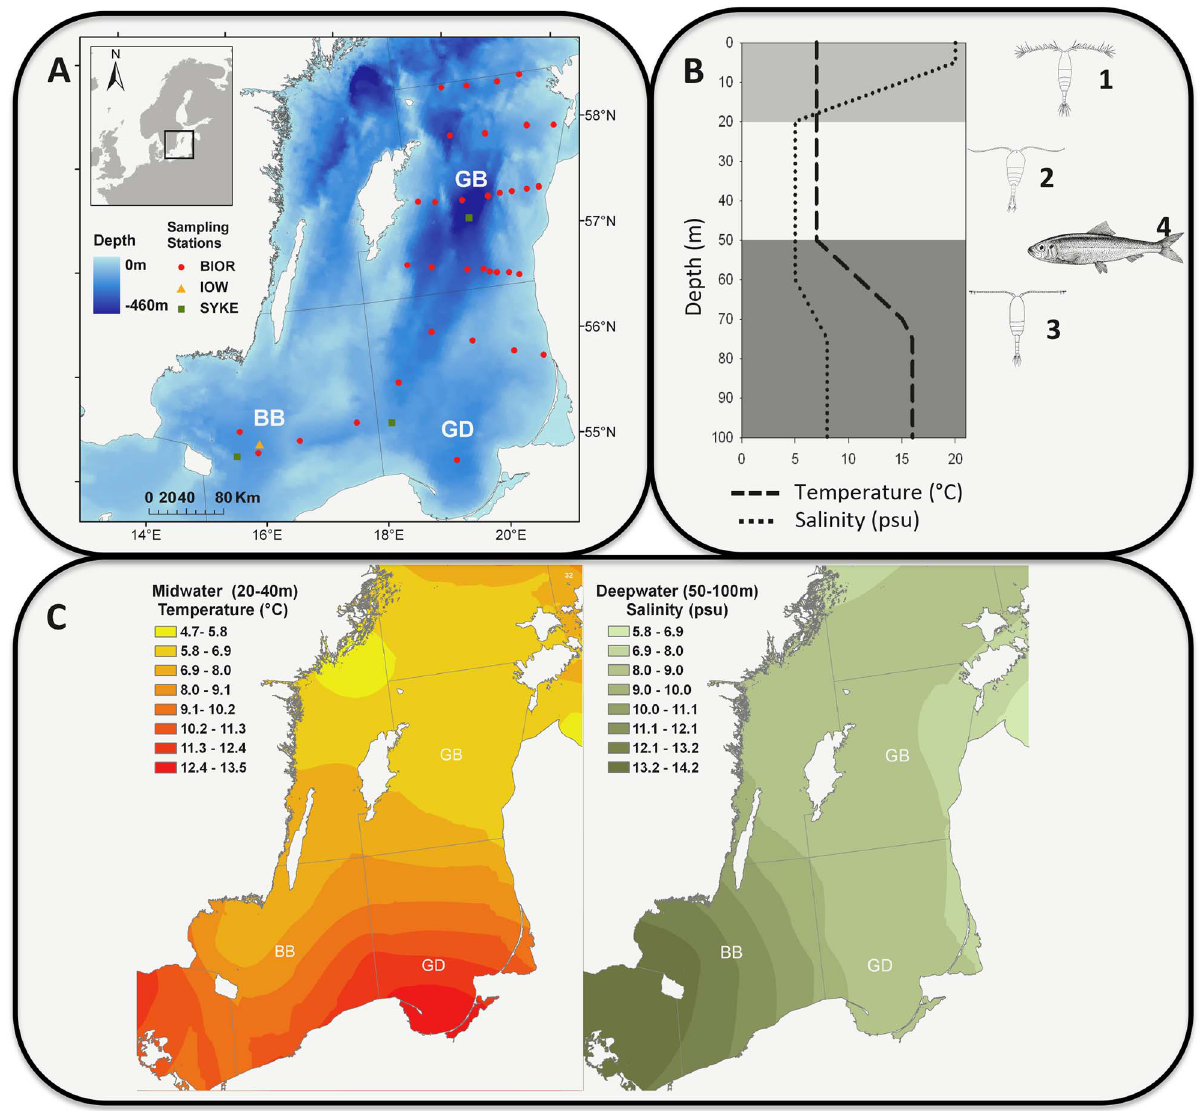
Figure 1. Study area. (A) Map of the Central Baltic Sea with its three basins (BB=Bornholm Basin, GD=Gdansk Deep, GB=Gotland Basin) including the sampling station of the different datasets. (B) Schematic vertical profile of the hydrology together with the copepod (1= Acartia spp., 2= Temora longicornis , 3= Pseudocalanus acuspes ) and predator distribution (4). (C) Horizontal profile of the hydrology in August 2001, i.e., the gradient in temperature and salinity at different water depths. The respective depth ranges were chosen based on the species most affected by these parameters in our analysis.